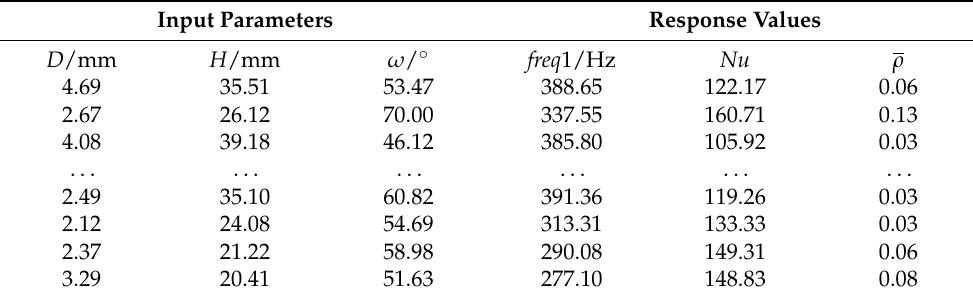
Table 2. Experimental design of the DOE optimal Latin hypercube.